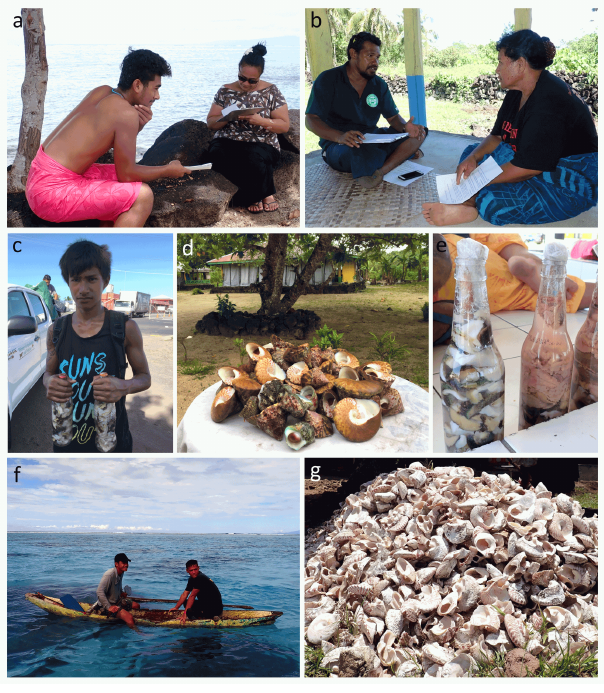
Fig. 2 . (a, b) Conducting interviews with trochus fishers; (c) a young fisher selling trochus ( Rochia nilotica ) flesh in bottles; (d) a pile of trochus shells on sale by the roadside in Savai’i; (e) trochus flesh in bottles for sale in a town market in Savai’i; (f) two Samoan fishers in a typical traditional paddle canoe during a trip to collect trochus and other seafood; (g) a pile of trochus shells broken by fishers in order to extract the uncooked flesh.